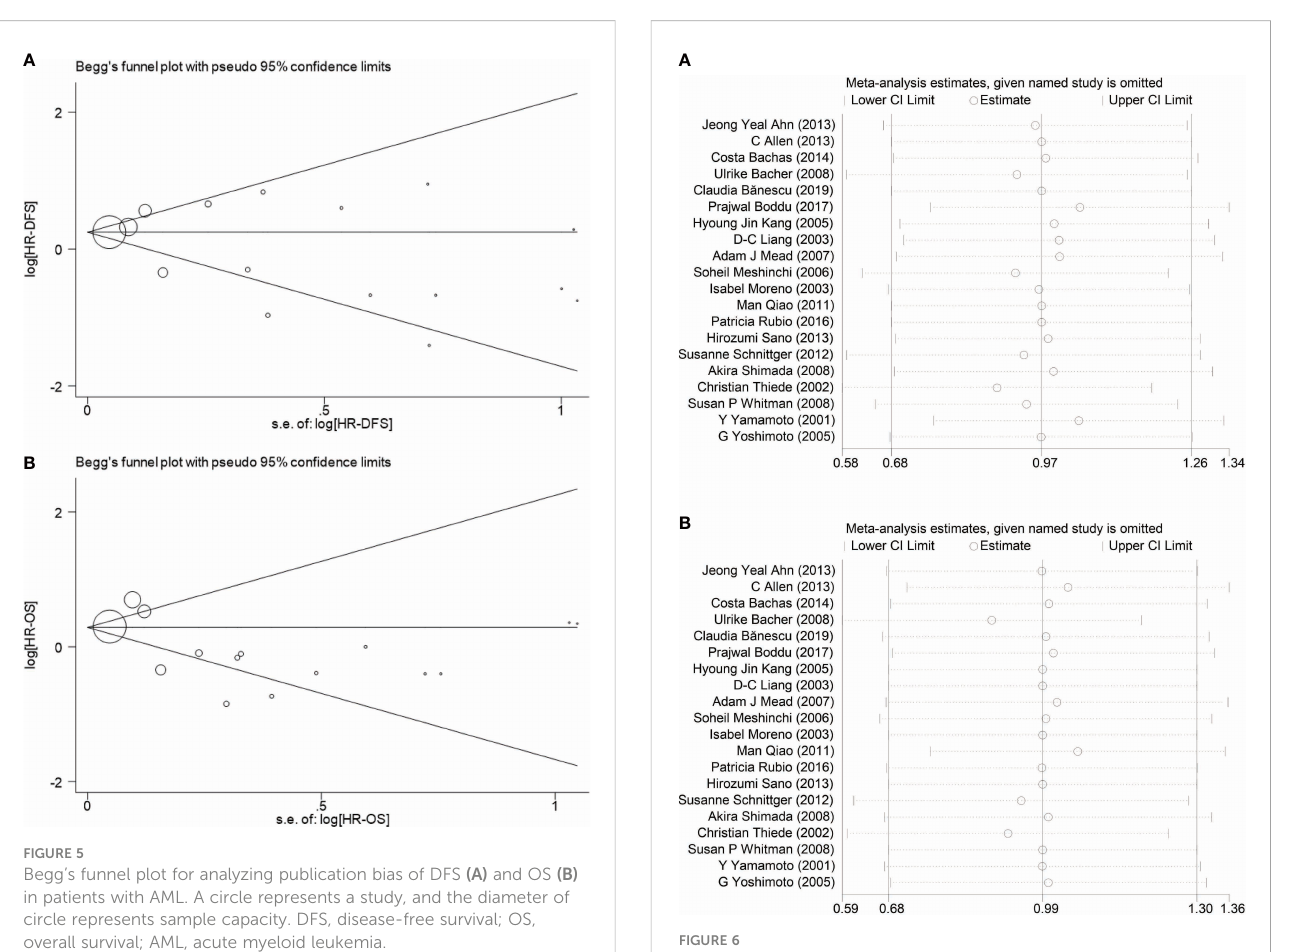
Sensitivity analysis of DFS (A) and OS (B) in patients with AML. DFS, disease-free survival; OS, overall survival; AML, acute myeloid